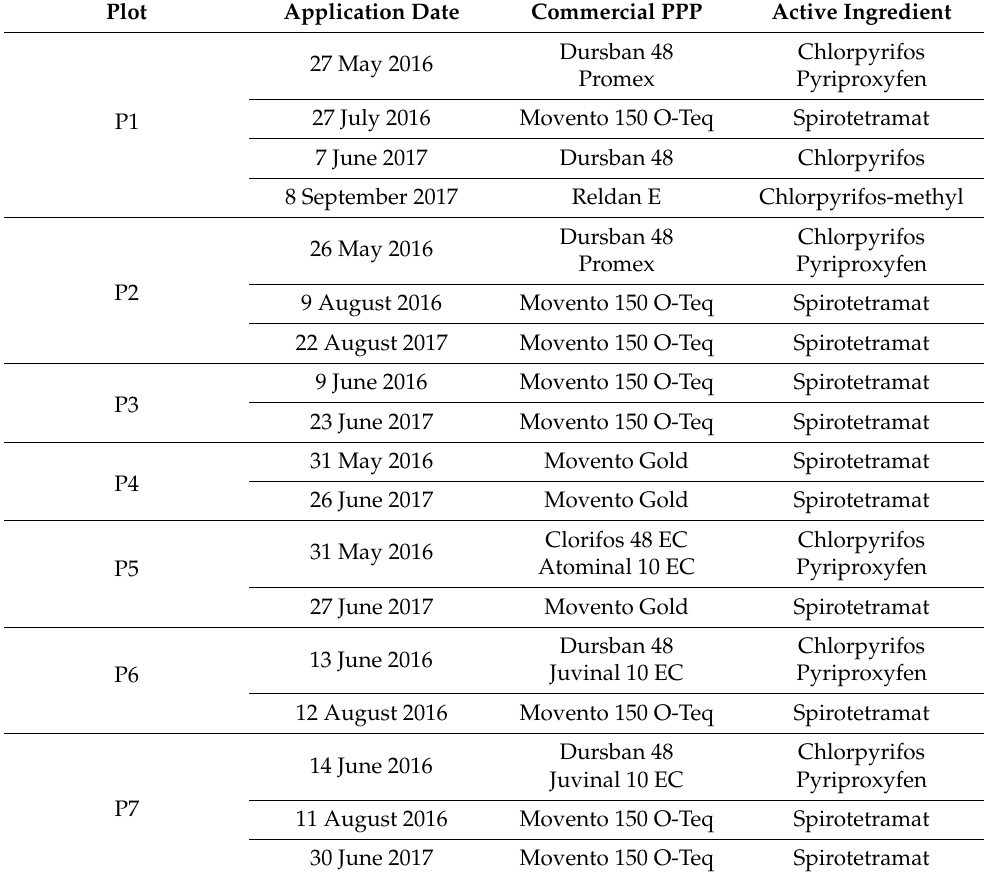
Table A1. Active ingredients of the plant protection products (PPPs) used in the spray applications against Aonidiella aurantii